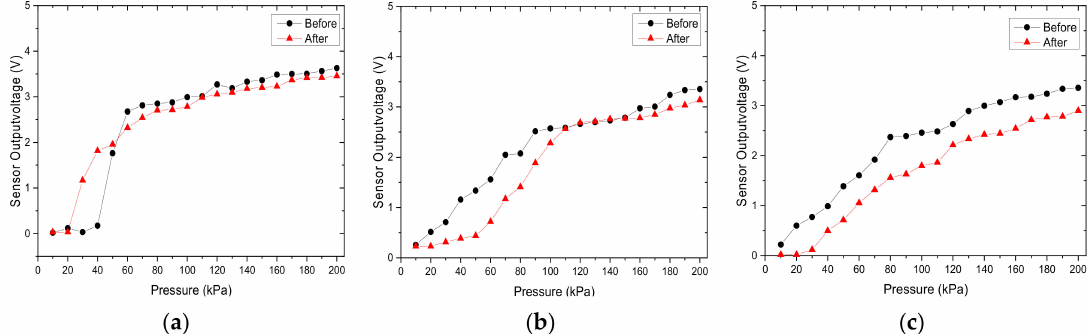
Figure 23. The difference in voltage output signal before and after 100 cycles of thermal testing for ( a ) sensor 1, ( b ) sensor 2, ( c ) sensor 3.